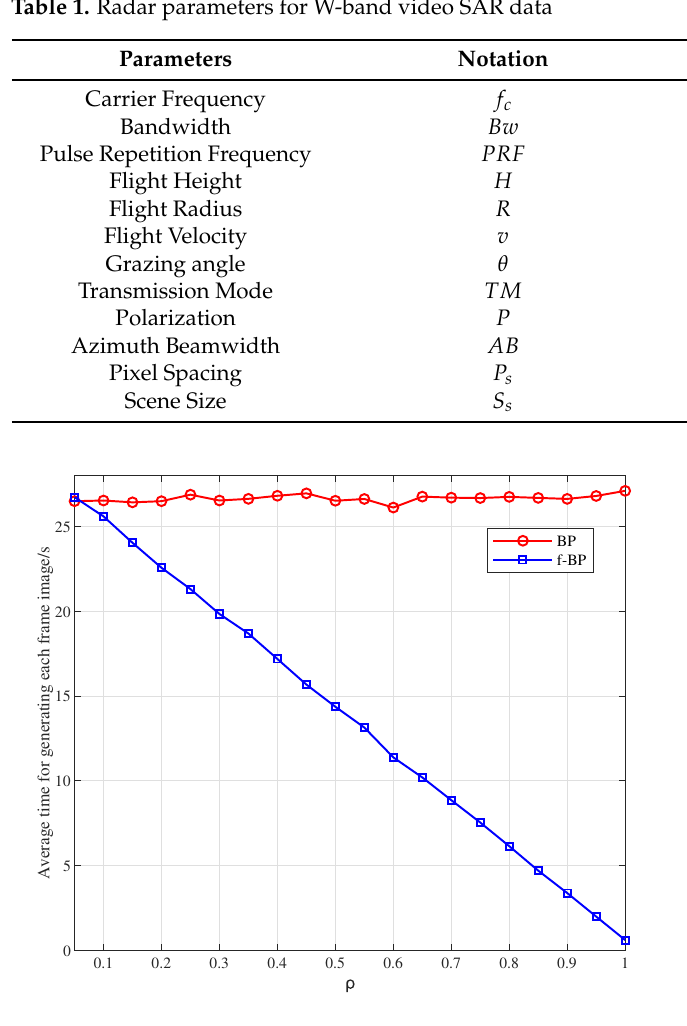
Figure 5. Comparison of the time of each frame generated by the back-projection method (BP) and the fast back-projection method (f-BP) with different overlapping